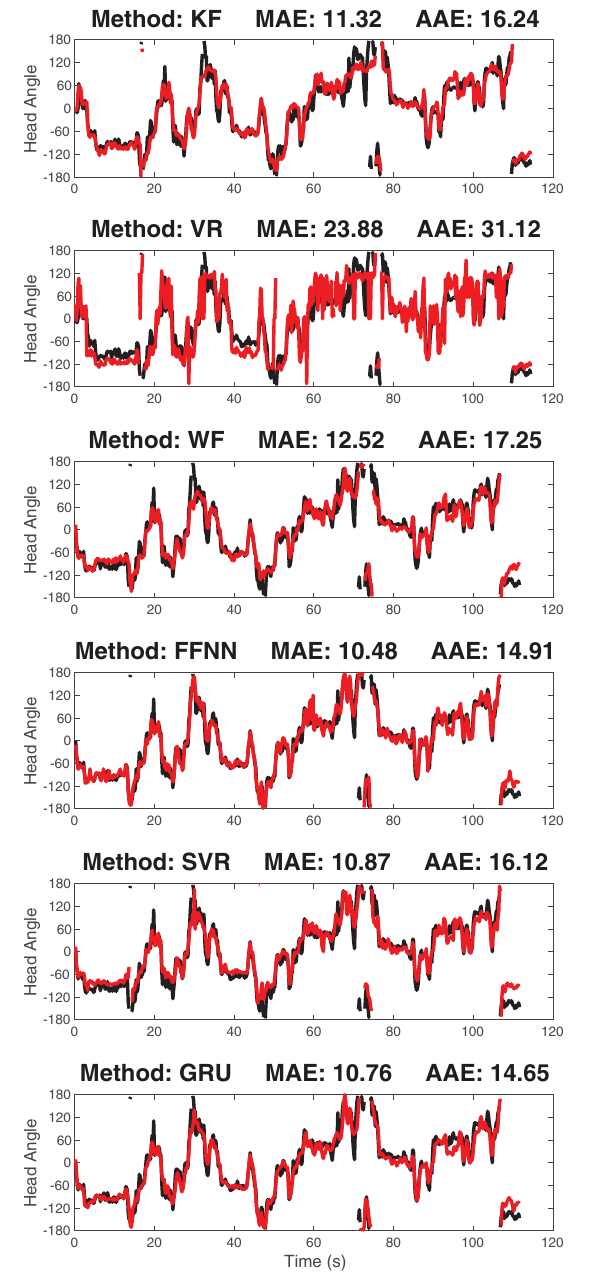
velocity and MAE was not significant for Kallman Filter, General Linear Model, and Optimal Linear Estimator methods (absolute value of the r s ≤ 0.27, p s ≥ 0.08), but was for all other methods (absolute value of the r s ≥ 0.34, p s <